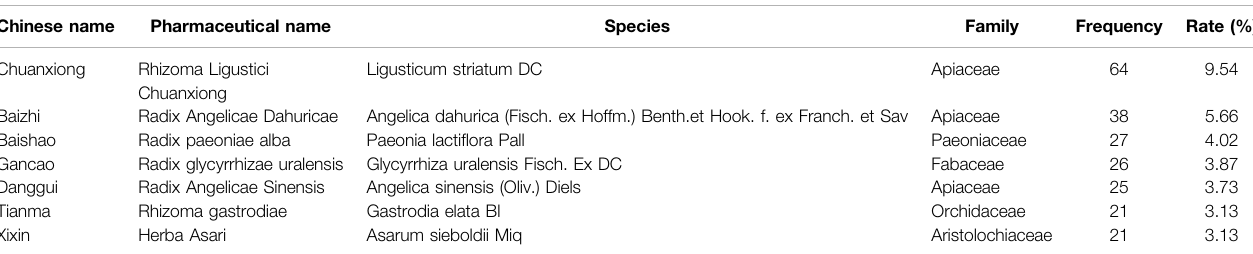
TABLE 3 | Details of frequently used herbs in CHM